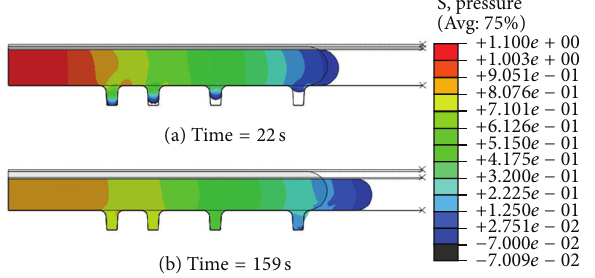
Figure 8: Filling situations at different times.